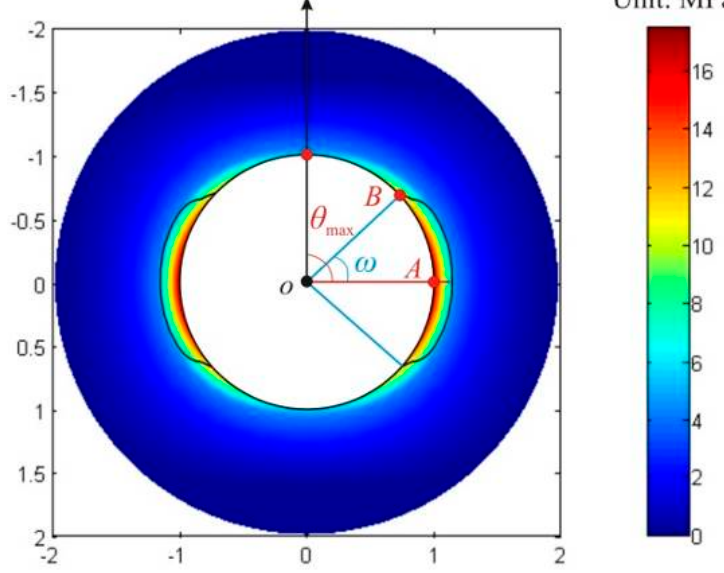
Figure 4. The required cohesion to keep wellbore stability (Modified from [2]).